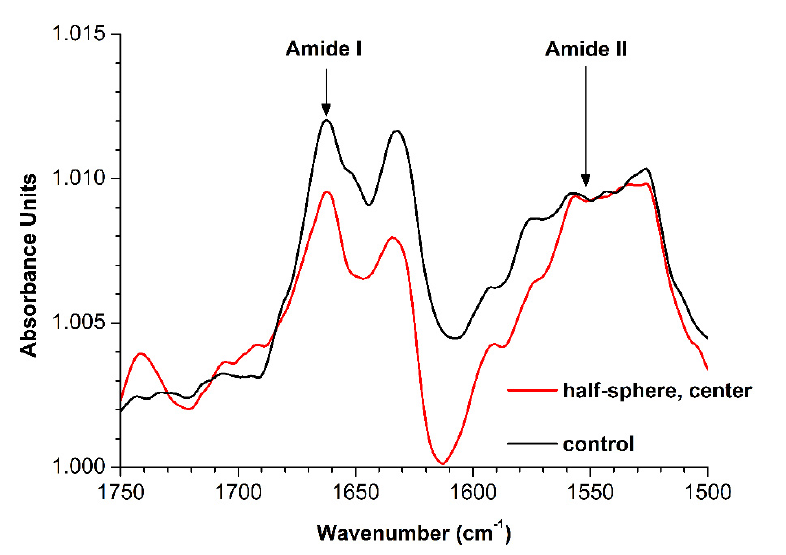
Figure 4. Typical attenuated total reflection Fourier transform infrared spectroscopy (ATR-FTIR) spectra of the HRP solution, incubated either in the center of the half-sphere (red) or 2 m away from the half-sphere (black). The HRP concentration was 10 − 4 M. Arrows indicate the characteristic Amide I (1660 cm − 1 ) and Amide II (1550 cm − 1 ) peaks.